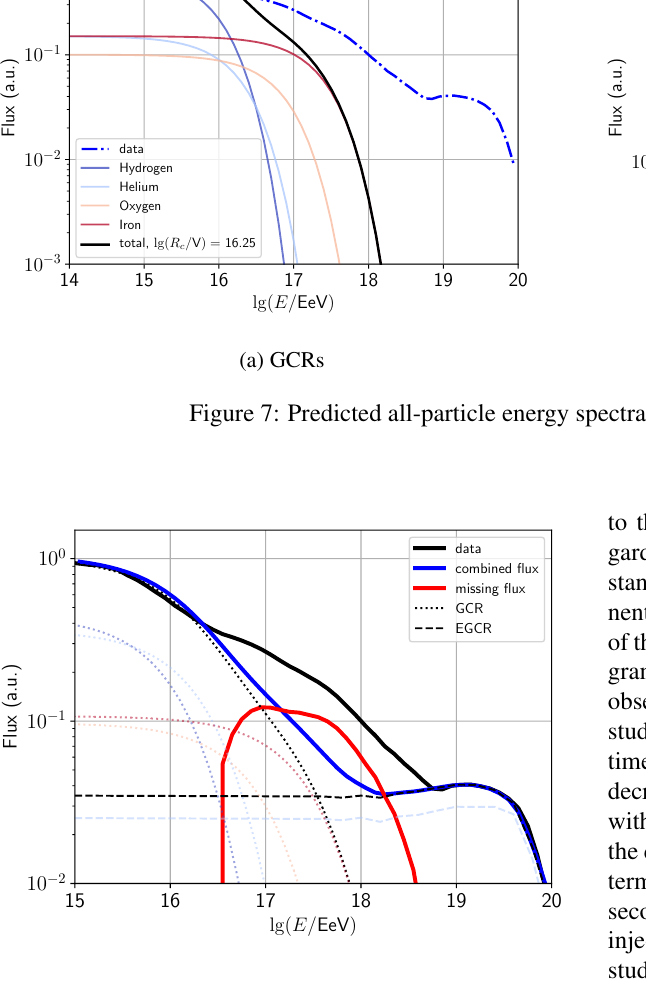
Figure 8: Total predicted all-particle energy